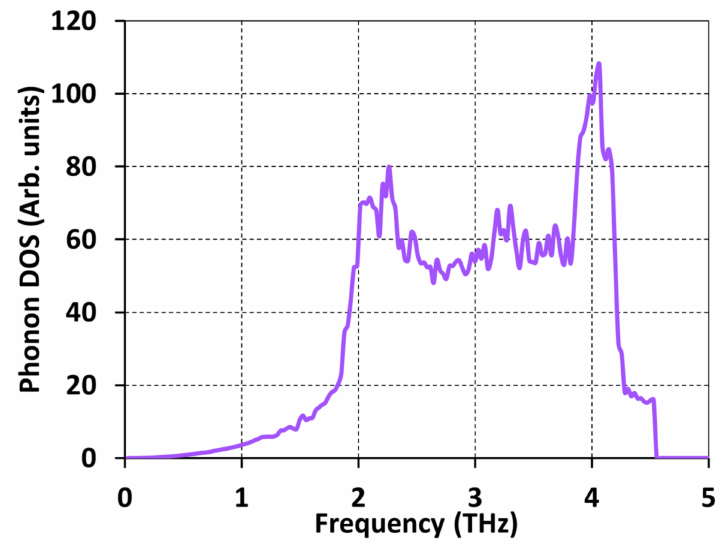
Figure 3. DFT-calculated phonon density of states for α - Y .